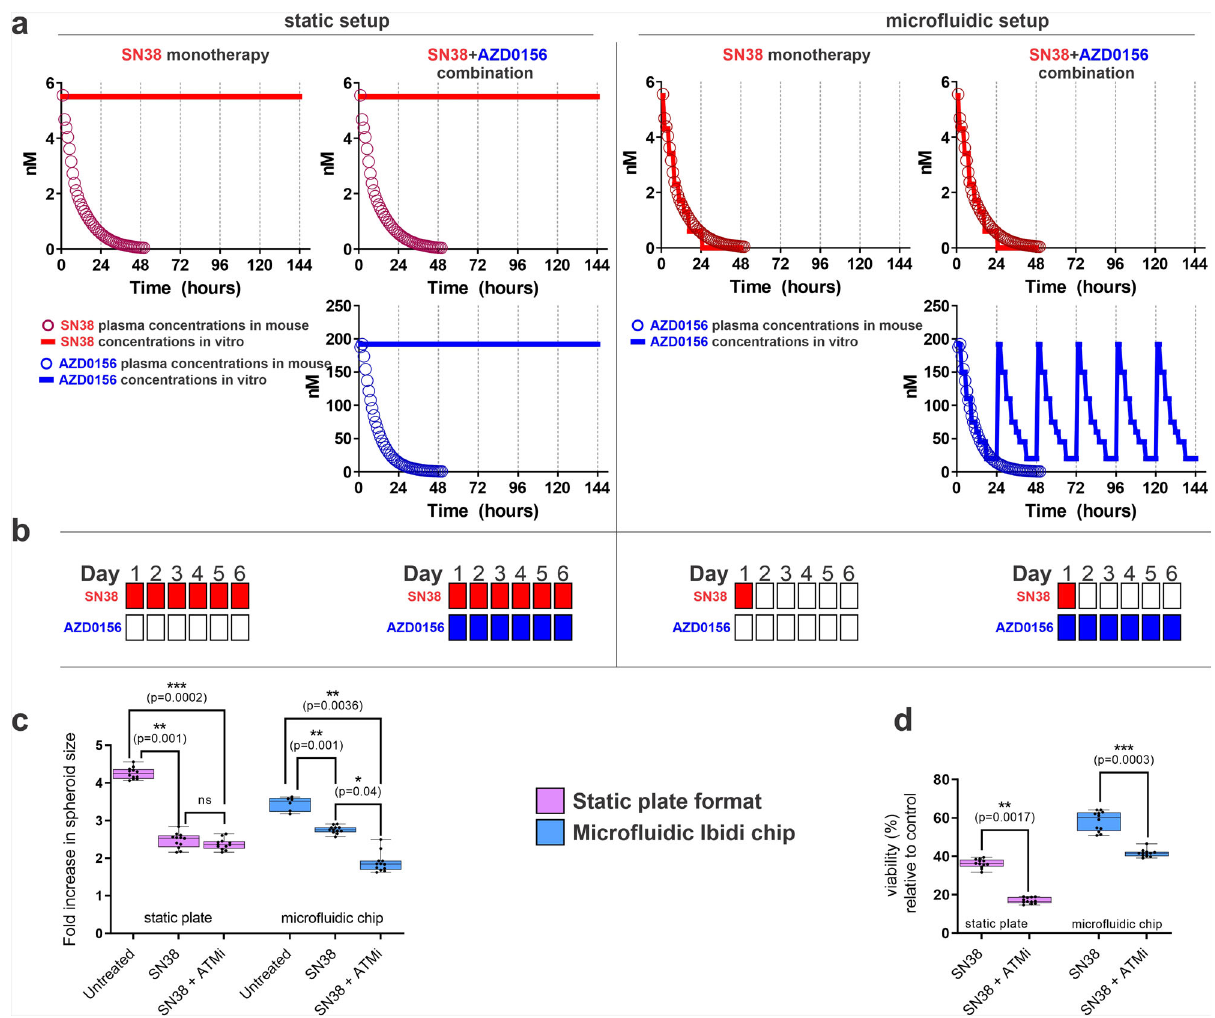
Fig. 2 Exposure pro fi le of SN38 and ATM inhibitor (AZD0156) in static plate format versus micro fl uidic Ibidi chip and consequence of different exposures on tumour cells response. a , b In static plate format, SW620 tumour spheroids were exposed to a fi xed dose corresponding to the maximum mouse plasma concentration achieved with 50 mg/kg dose of irinotecan (SN38 Cmax 5.5 nM), and 10 mg/kg AZD0156 (Cmax 192 nM) continuously for 6 days. In micro fl uidic Ibidi chip, tumour spheroids were exposed to eight different concentrations in a gradient fashion mimicking the in vivo pharmacokinetic pro fi le and treatment schedule for both drugs. c Spheroids were imaged in situ (plate/chip) at the end of the treatment and their volumes calculated from average radius deducted from min/max Feret. d Spheroid viability was measured at the end of the treatment by CellTiterGlo assay ( d ). N = 6 per condition from two independent experiments. Box-plots show median (centre line); box limits are 25th to 75th percentile; whiskers represent min and max values. Statistical analysis was performed using 1-way ANOVA. Table 2 Treatment schedules for SN38 and AZD0156 assessed in the micro fl uidic setup, on Matrigel-encapsulated SW620